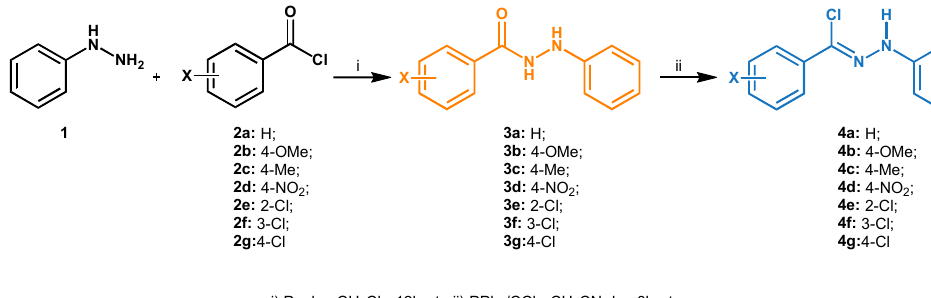
Table 1. Optimization of reaction conditions.